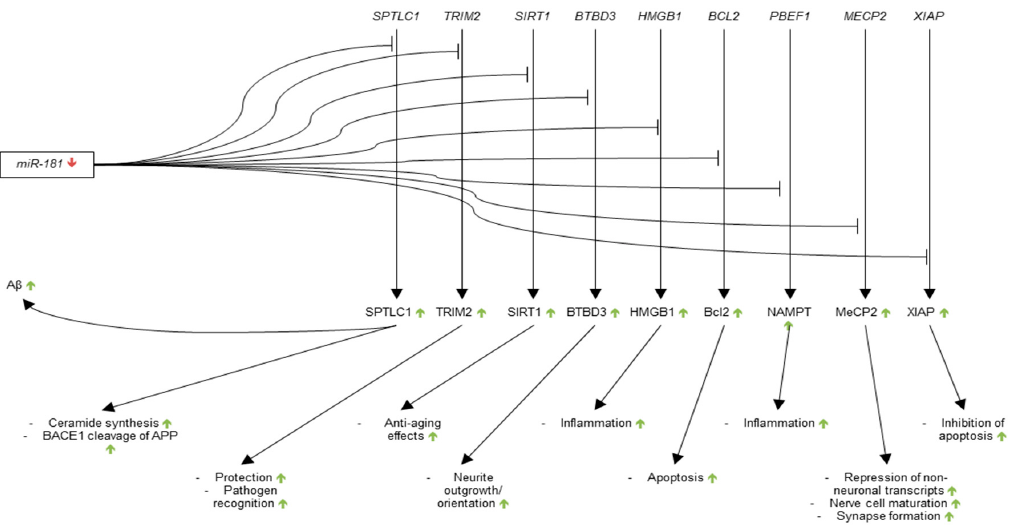
Figure 3. Regulation by miR-181. miR-181 inhibits the translation of Serine Palmitoyltransferase Long Chain Base Subunit 1 (SPTLC1), tripartite motif-containing 2 (TRIM2), silent mating type information regulation 2 homolog 1 (SIRT1), BTB Domain Containing 3 (BTBD3), high-mobility group protein 1 (HMGB1), B-cell lymphoma 2 (Bcl2), Nicotinamide phosphoribosyltransferase (NAMPT), methyl CpG binding protein 2 (MeCP2), and X-linked inhibitor of apoptosis (XIAP). The decreased levels of miR-181 in AD brain are denoted by the red arrow. The green arrows denote the hypothetical upregulation of the targeted proteins and their cellular effects.